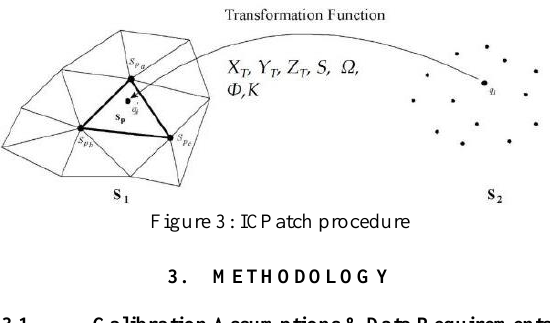
Figure 3: ICPatch procedure